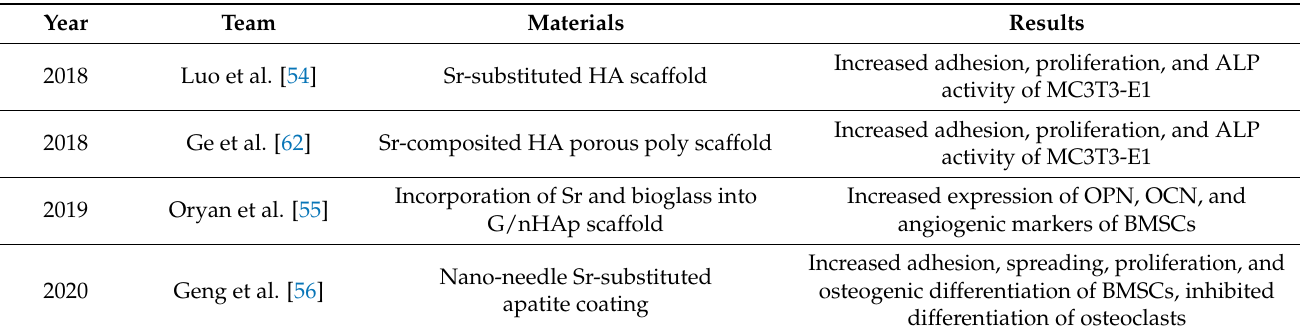
Table 1. The application of Sr compound with hydroxyapatite